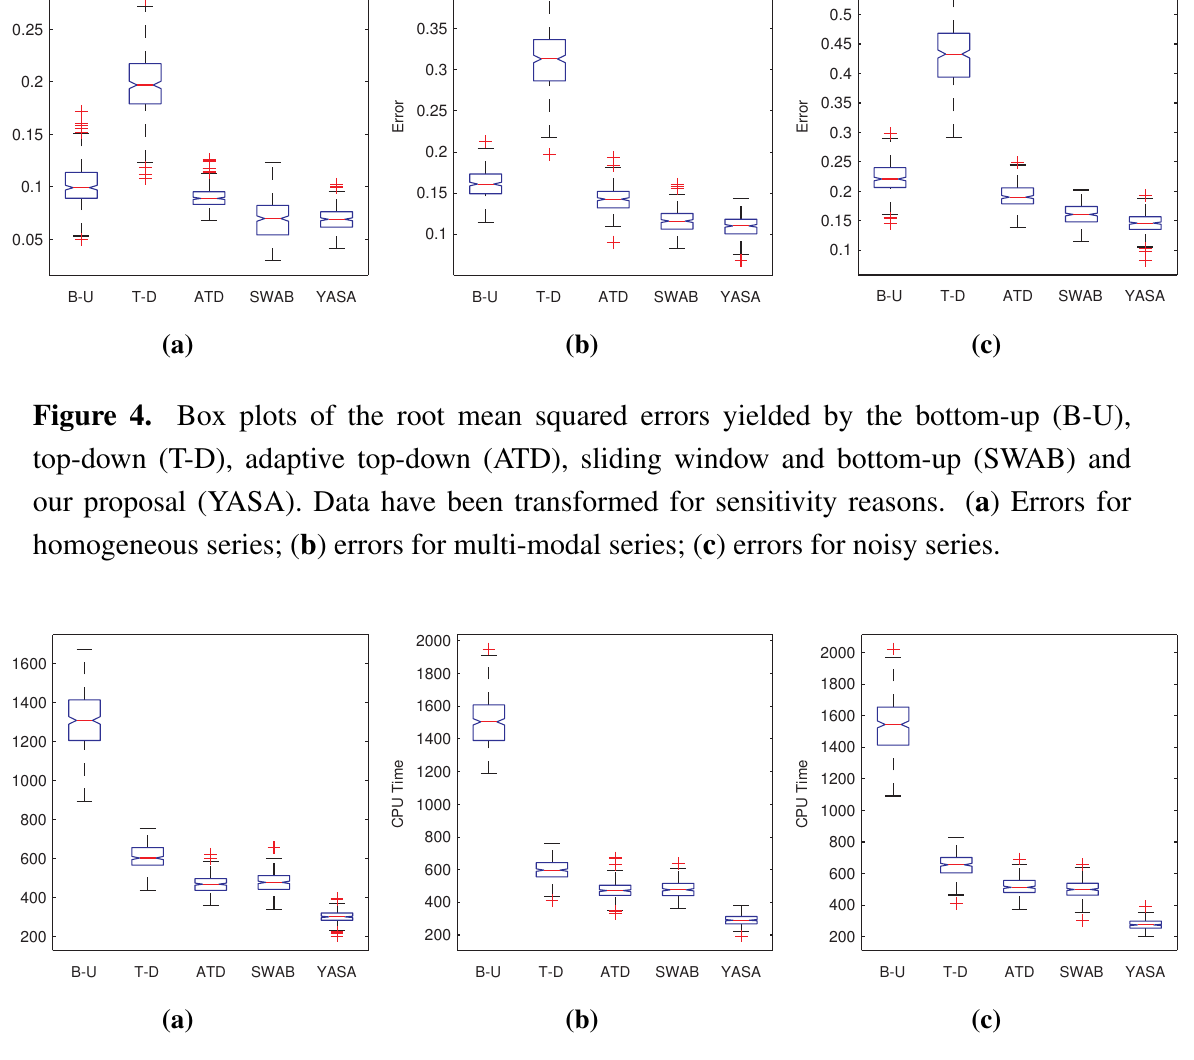
Figure 5. Box plots of the CPU time needed by the B-U, T-D, ATD, SWAB and our proposal (YASA). Data have been transformed for sensitivity reasons. ( a ) Errors for homogeneous series; ( b ) errors for multi-modal series; ( c ) errors for noisy